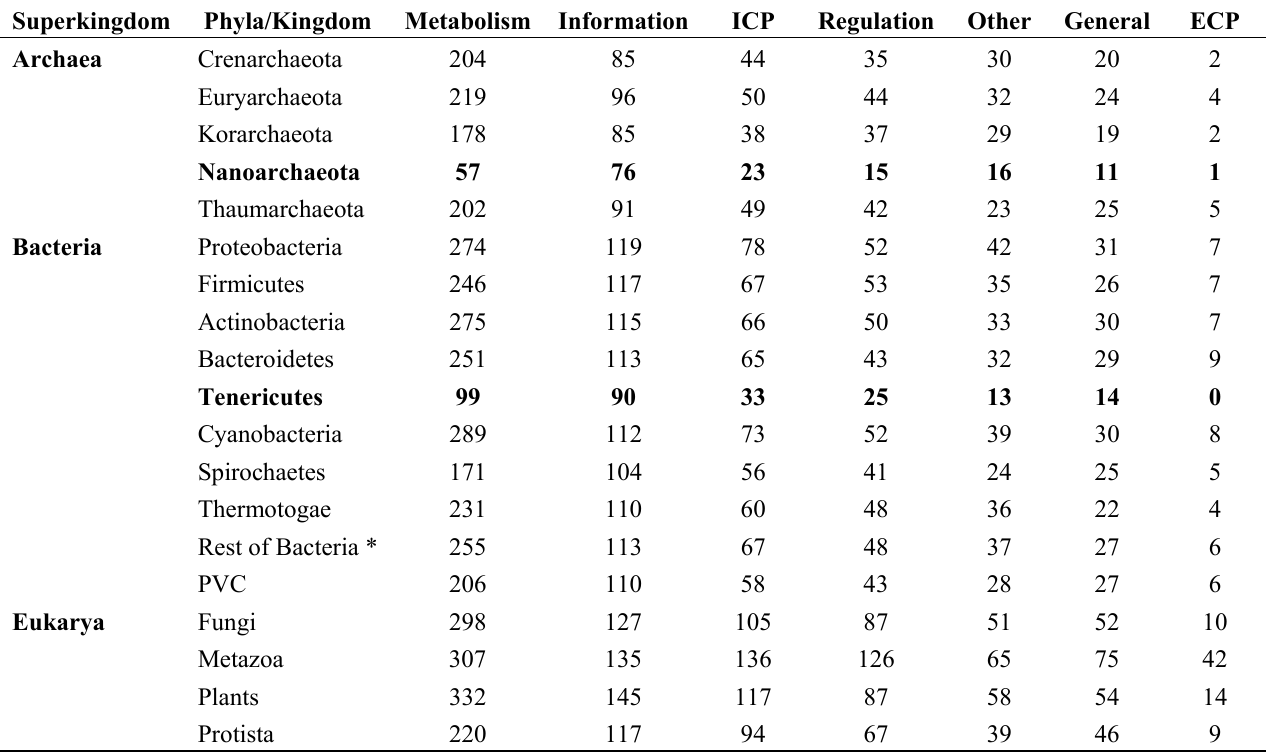
Table S1. Average number of FSF domains in each phyla/kingdom corresponding to the seven general functional categories. Numbers were rounded up when the decimal value exceeded 0.5 and rounded down otherwise. Nanoarchaeota and Tenericutes have the least number of metabolic domains and are highlighted in bold. Eukaryal kingdoms (Fungi, Metazoa, Plants and Protista) have the richest FSF repertoires compared to the prokaryotes. Superkingdom Archaea